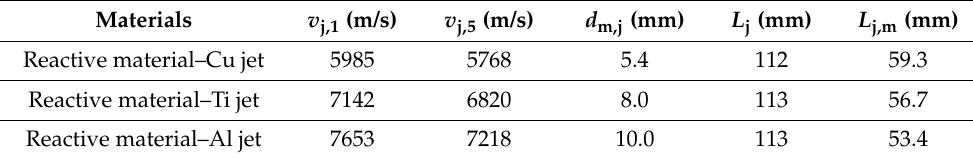
Table 5. Performance parameters of the three kinds of reactive material composite jets.